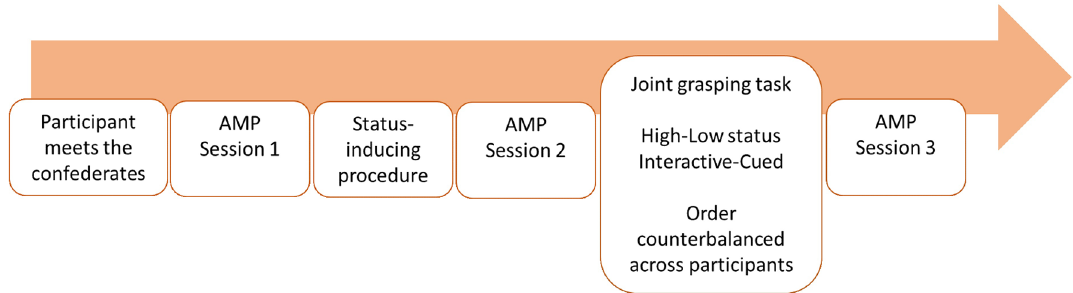
Figure 3. Experiment timeline. AMP = Affect Misattribution